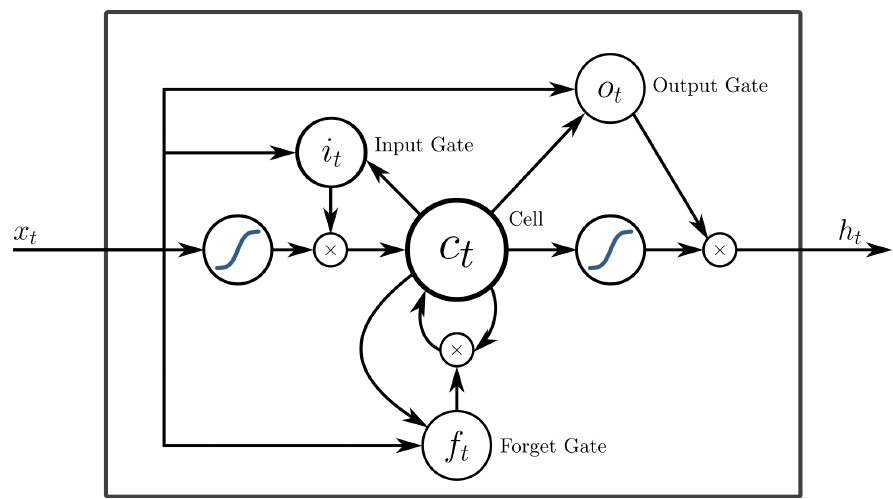
Figure 2. Long Short Term Memory (LSTM) unit. For the sake of simplicity biases are